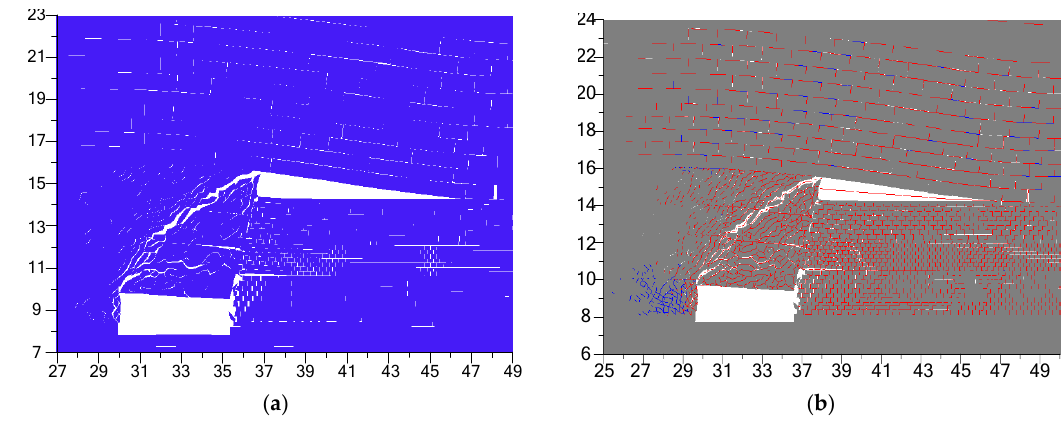
Figure 8. Simulated failure patterns in the entry-surrounding rock: ( a ) Macroscopic fracture evolution; ( b ) microcosmic crack evolution. Tensile and shear cracks are marked by red and blue, respectively.